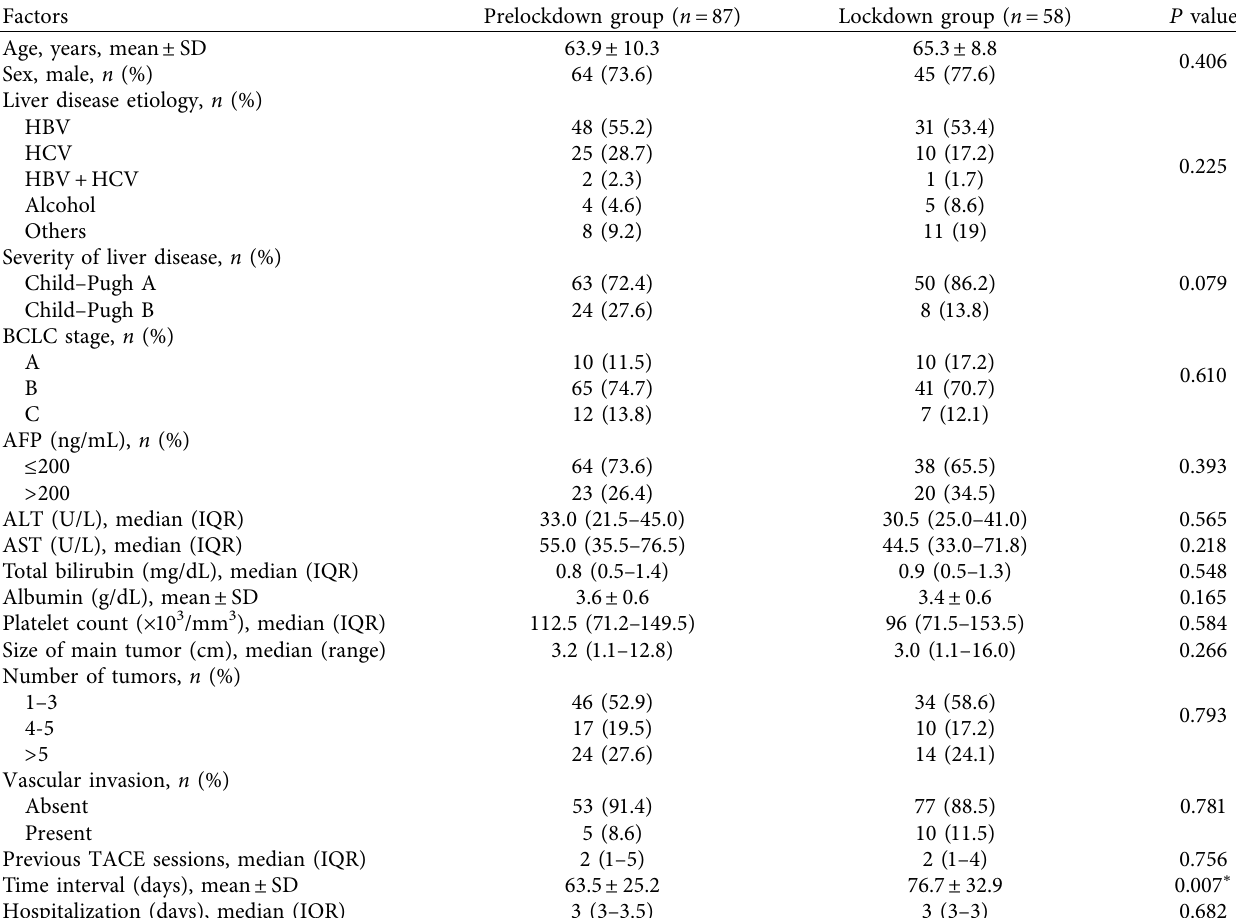
Table 3: Baseline characteristics of the study participants who underwent repeated TACE.